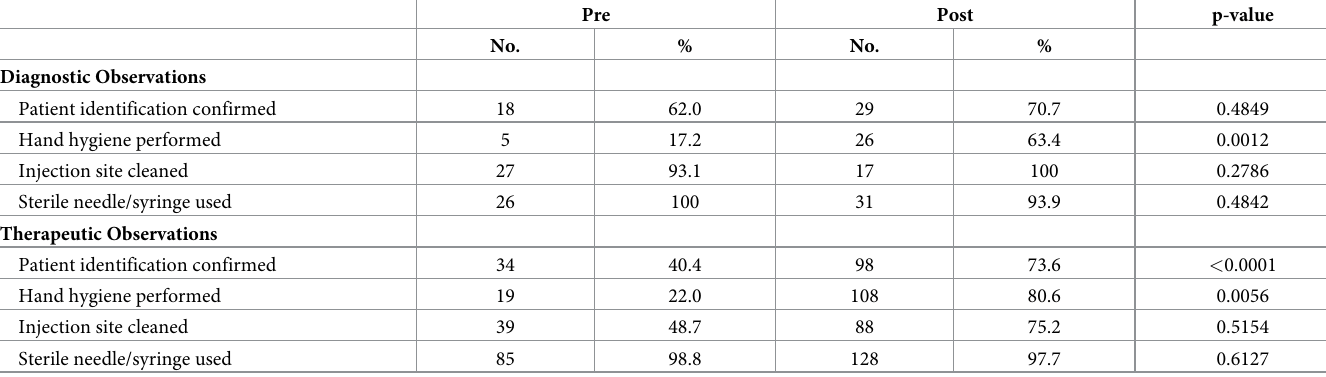
Table 2. Combined pre- and post-training assessment of safe injection practice affecting patient safety.